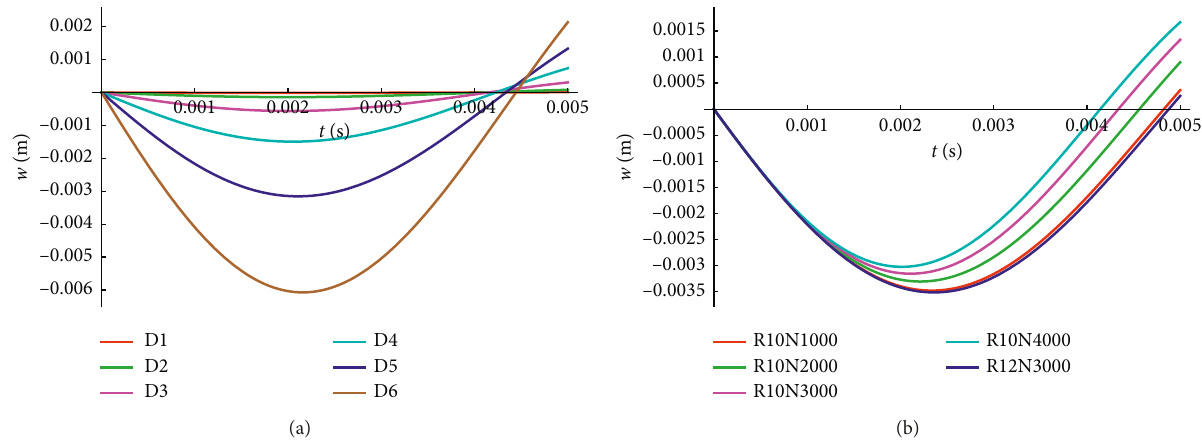
Figure 23: First trough of time histories of first-order vibration: (a) the arch-to-span ratio is 1/10, pretension level is 3000N/m, and hailstone diameters increased from 1.0 to 6.0cm (D1 to D6); (b) the hailstone diameter is 5.0cm, the arch-to-span ratio are 1/12 and 1/10 (R10 and R12), and pretension levels increased from 1000 to 4000N/m (N1000 to N4000).